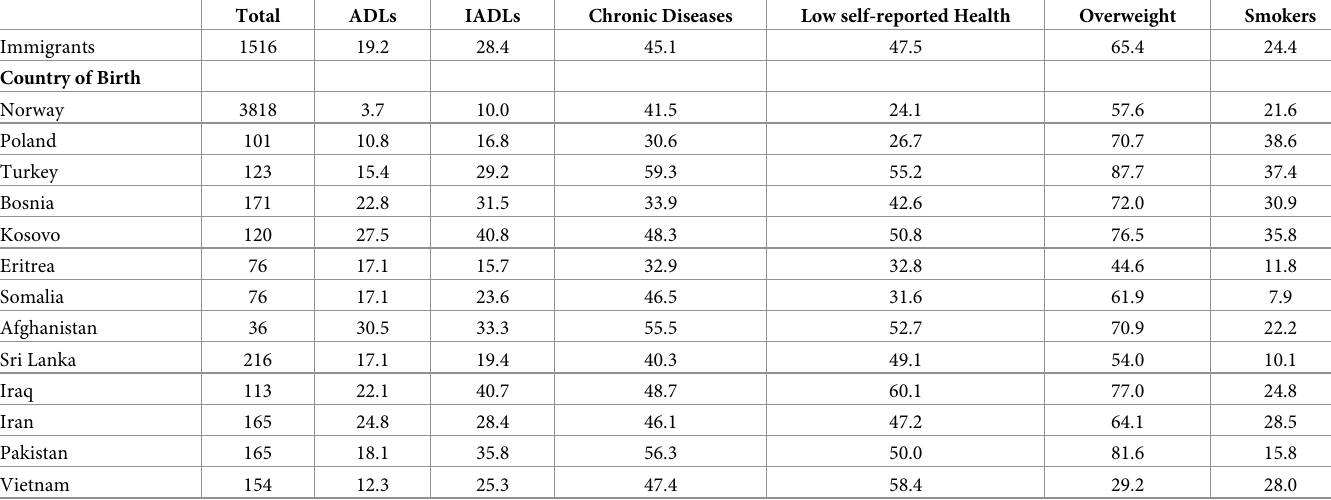
Table 1. Percentage of participants with health problems, low self-reported health and risk factors. Total